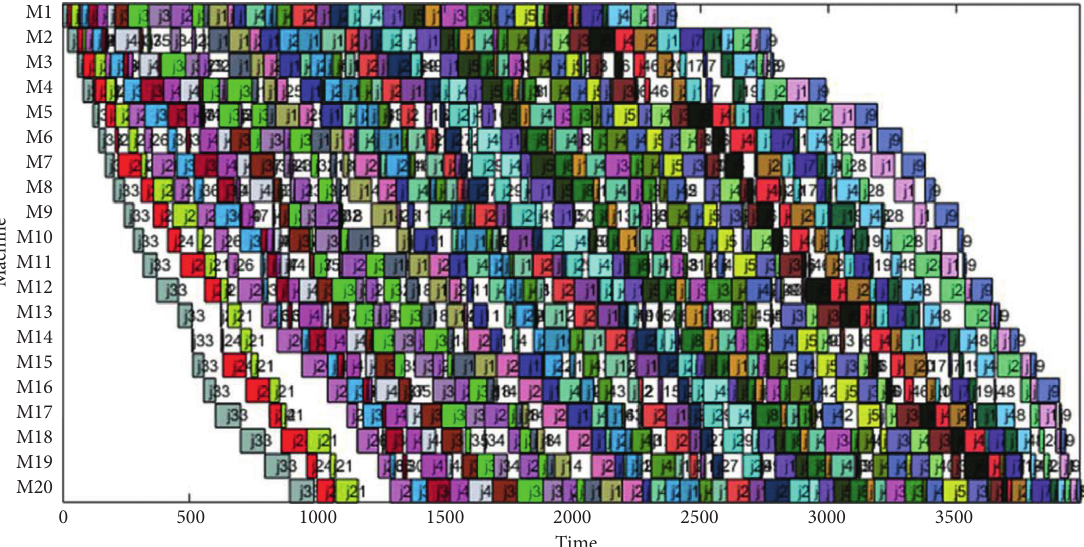
Figure 11: Gantt chart of the solution with IGSFLA-no-disturbance (workpiece: 50, machine: 20, makespan: